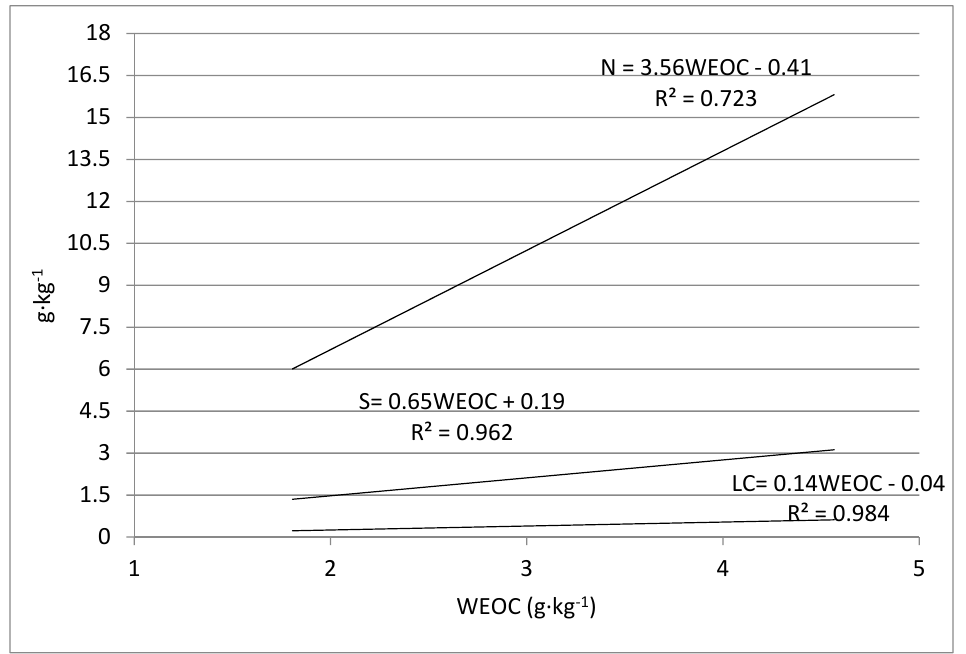
Figure 10. Linear regression for water extractable organic carbon (WEOC) and labile carbon (LC), N and S in composts.